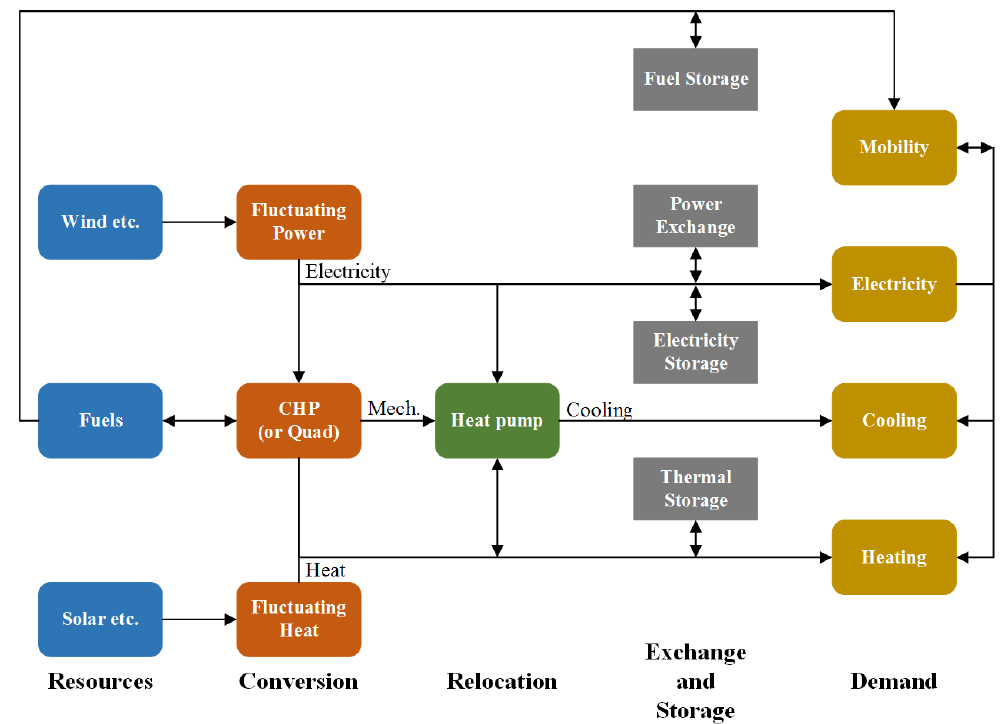
Figure 1. Third generation renewable energy system framework (adapted from [39]). CHP, combined heat and